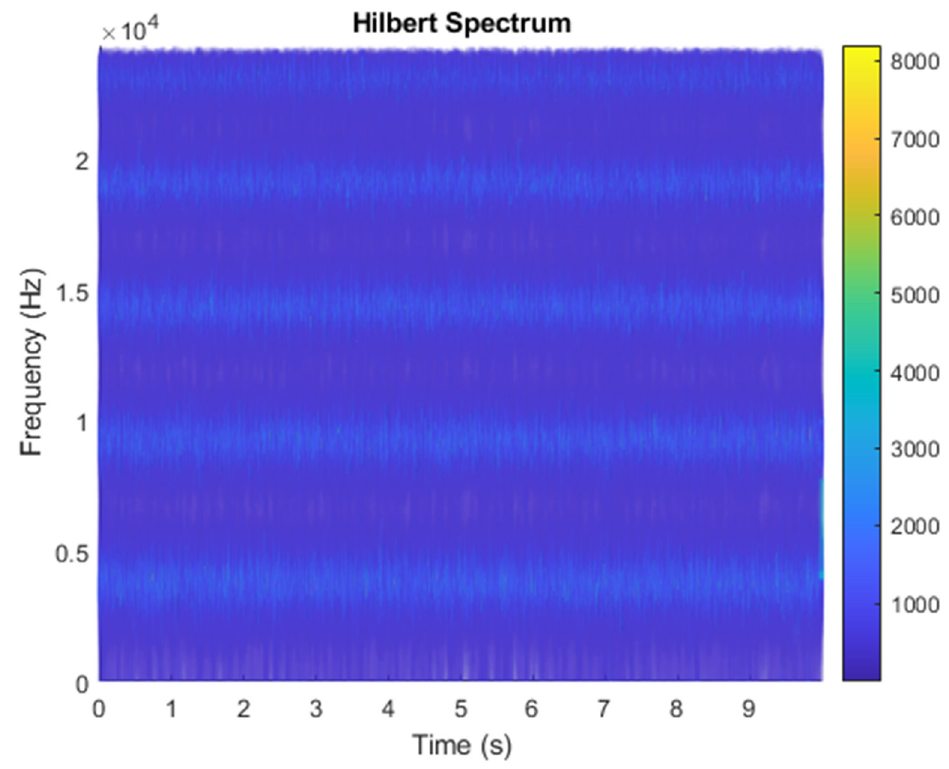
Figure 23. Hilbert Spectrum results of the VMD component obtained from the numerical simulation of the sensor.